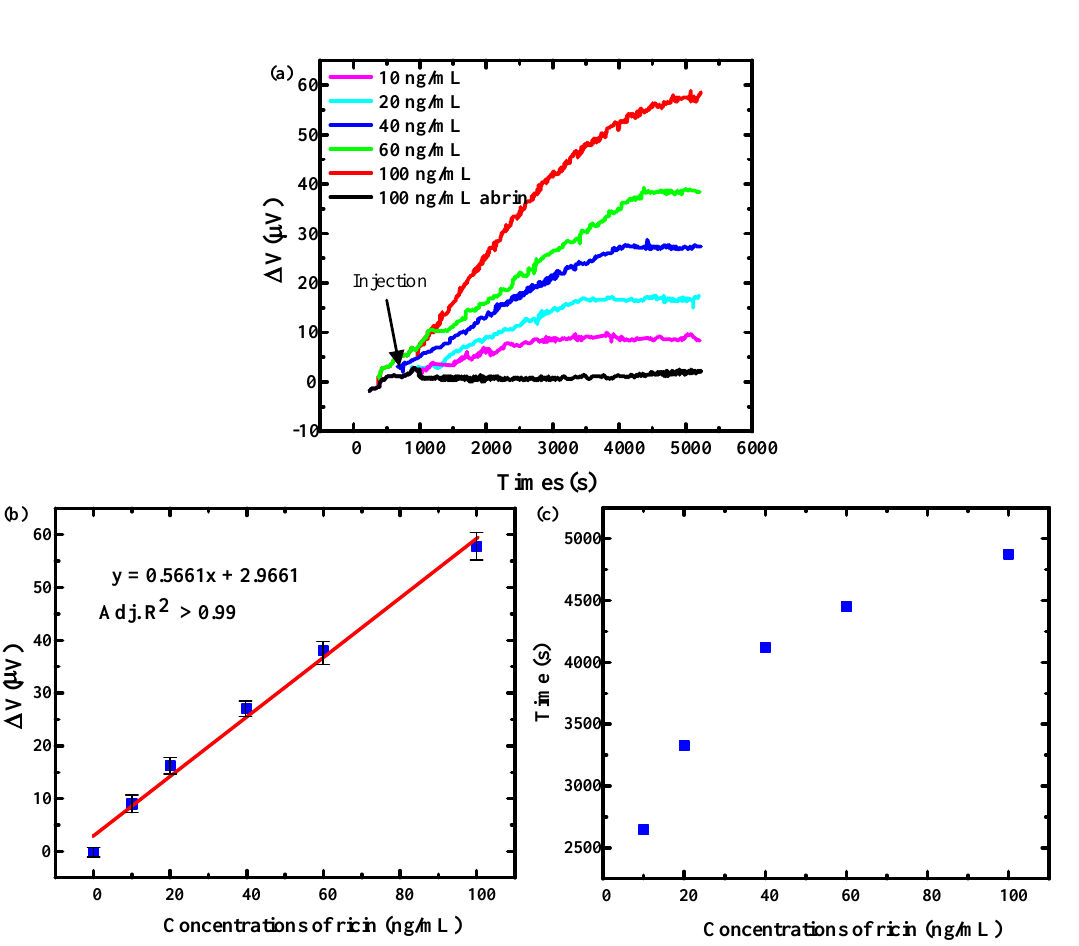
( a ) The output voltage curve of the microcantilever aptamer sensors at detecting Figure 9. ( a ): The output voltage curve of the microcantilever aptamer sensors at detecting concentration of 10–100 ng / mL ricin ( b ) Linear relationship between microcantilever response voltage concentration of 10–100 ng/mL ricin ( b ): Linear relationship between microcantilever response and detection concentration. ( c ) The relationship between the microcantilever response time and the voltage and detection concentration. ( c ): The relationship between the microcantilever response time ricin and the ricin concentration.